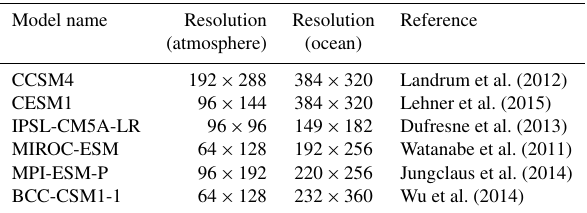
Table 1. CMIP5–PMIP3 model